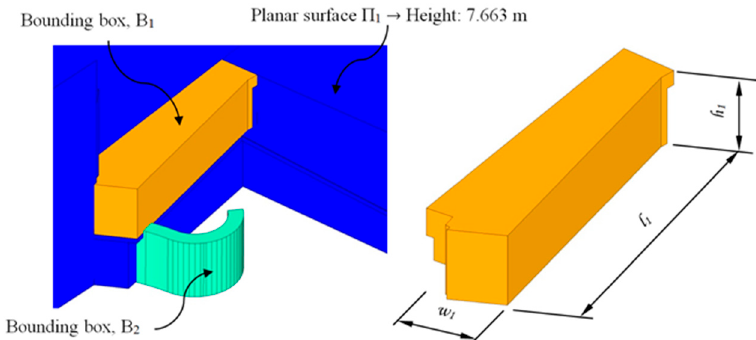
Figure 8. Generation of the B 1 bounding box of the BIM construction element E 1 based on the geometric and topological requirements of the urban environment.